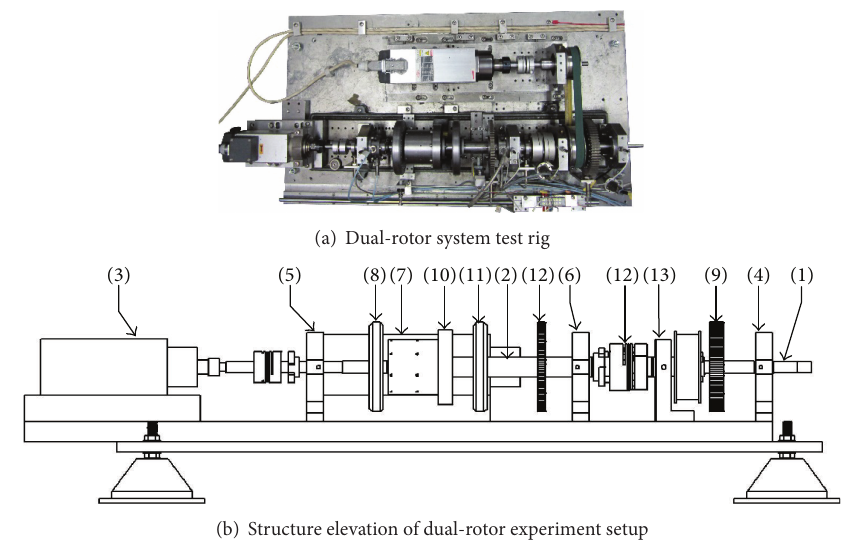
Figure 1: Dual-rotor system test rig and structure diagram.